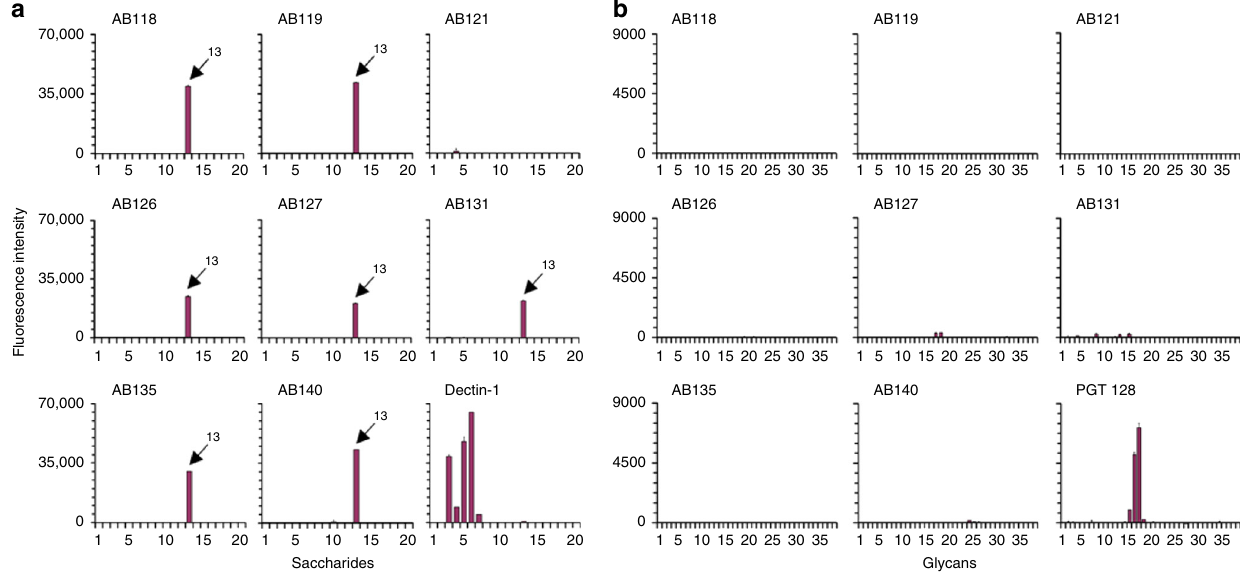
Fig. 4 Glycan microarray screening analyses of anti- Candida mAbs. a Binding of the anti- Candida mAbs and human Fc-tagged murine dectin-1 to the Fungal, Bacterial and Plant Polysaccharide Array (Supplementary Table 7). The information on the saccharide IDs and predominant oligosaccharide sequences is in Supplementary Table 7. The results are shown as histograms at 0.1 ng/spot (saccharide IDs 1 – 19) and at 5 fmol/spot (saccharide ID 20). The C. albicans mannoprotein (ID 13) is highlighted in the antibody panels. Values represent mean fl uorescence intensities ± errors (half of the difference of signal intensities of duplicate spots for each saccharide/glycan probe) ( n = 2). b Binding of the anti- Candida mAbs and mAb PGT 128 to the N -glycan Array Set 3 (Supplementary Table 8). These arrays are at 5 fmol/spot. Values represent mean fl uorescence intensities ± errors (half of the difference of signal intensities of duplicate spots for each glycan probe) ( n = speci fi c antigens whose expression levels varies from species to species.